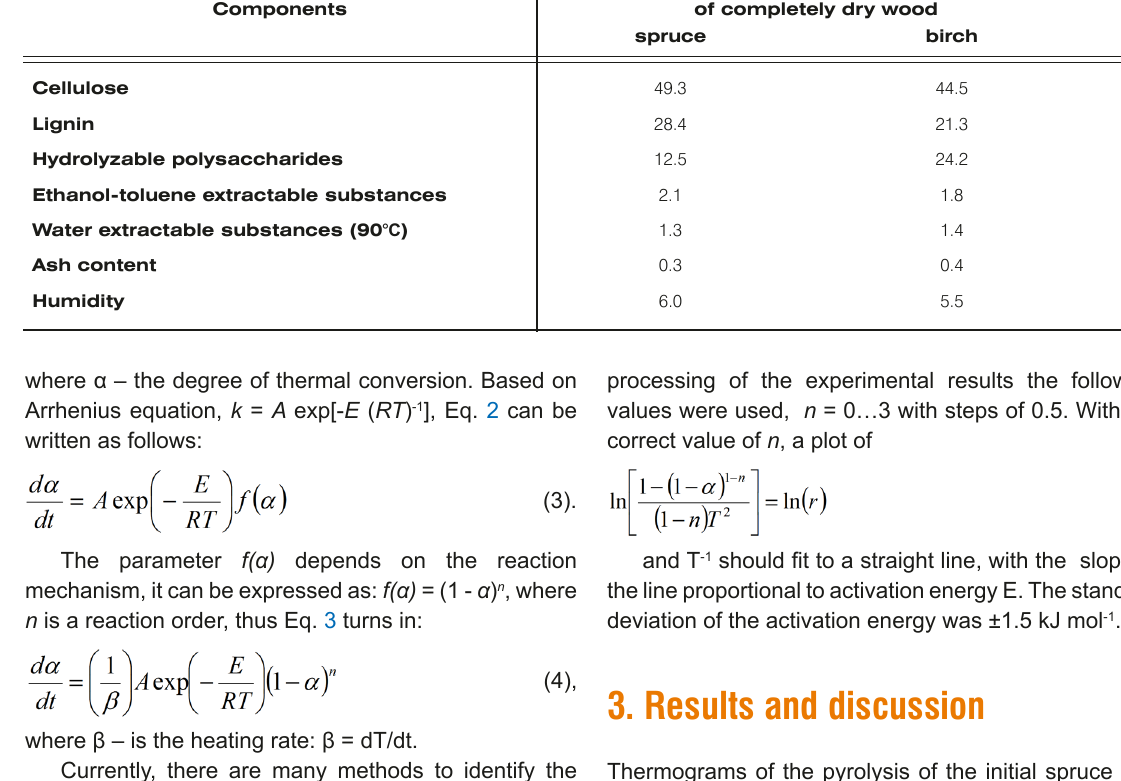
Table 1. Component composition of the raw wood.